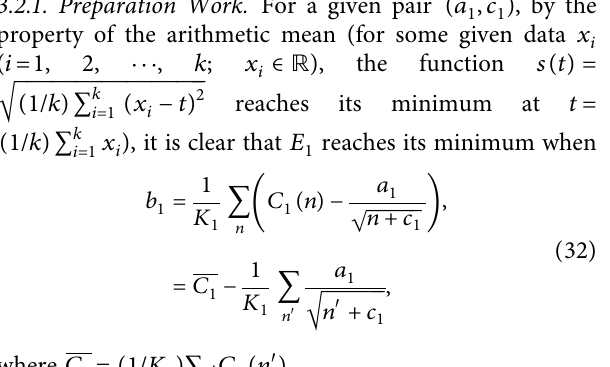
Figure 4: The graph of the data ( n, ( 3/2 π 2 )( ln ( 12